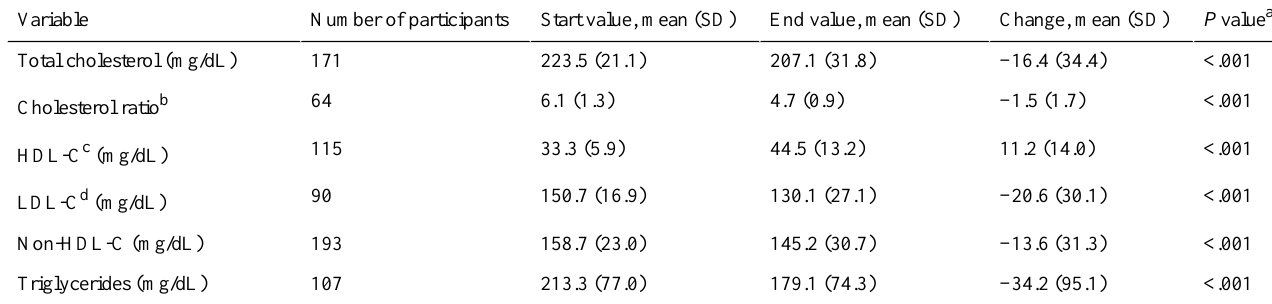
Table 3. Changes in lipid levels among users with elevated lipid